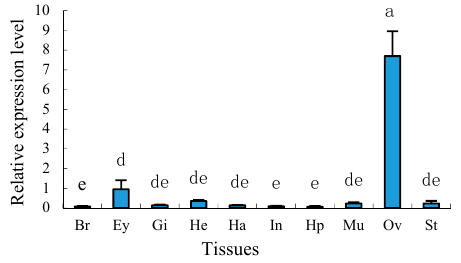
Figure 8. Distribution pattern of Sp-uchl5 in various tissues. Br: brain; Gi: gill; He: heart; Ha: haemolymph; In: intestine; Hp: hepatopancreas; Mu: muscle; Ov: ovary; St: stomach. The lowercase letters above error bars signify difference as follows: The same letters are not significantly different ( p > 0.05), the adjacent letters are significantly different ( p < 0.05), and the intervallic letters are extremely significantly different ( p < 0.01).